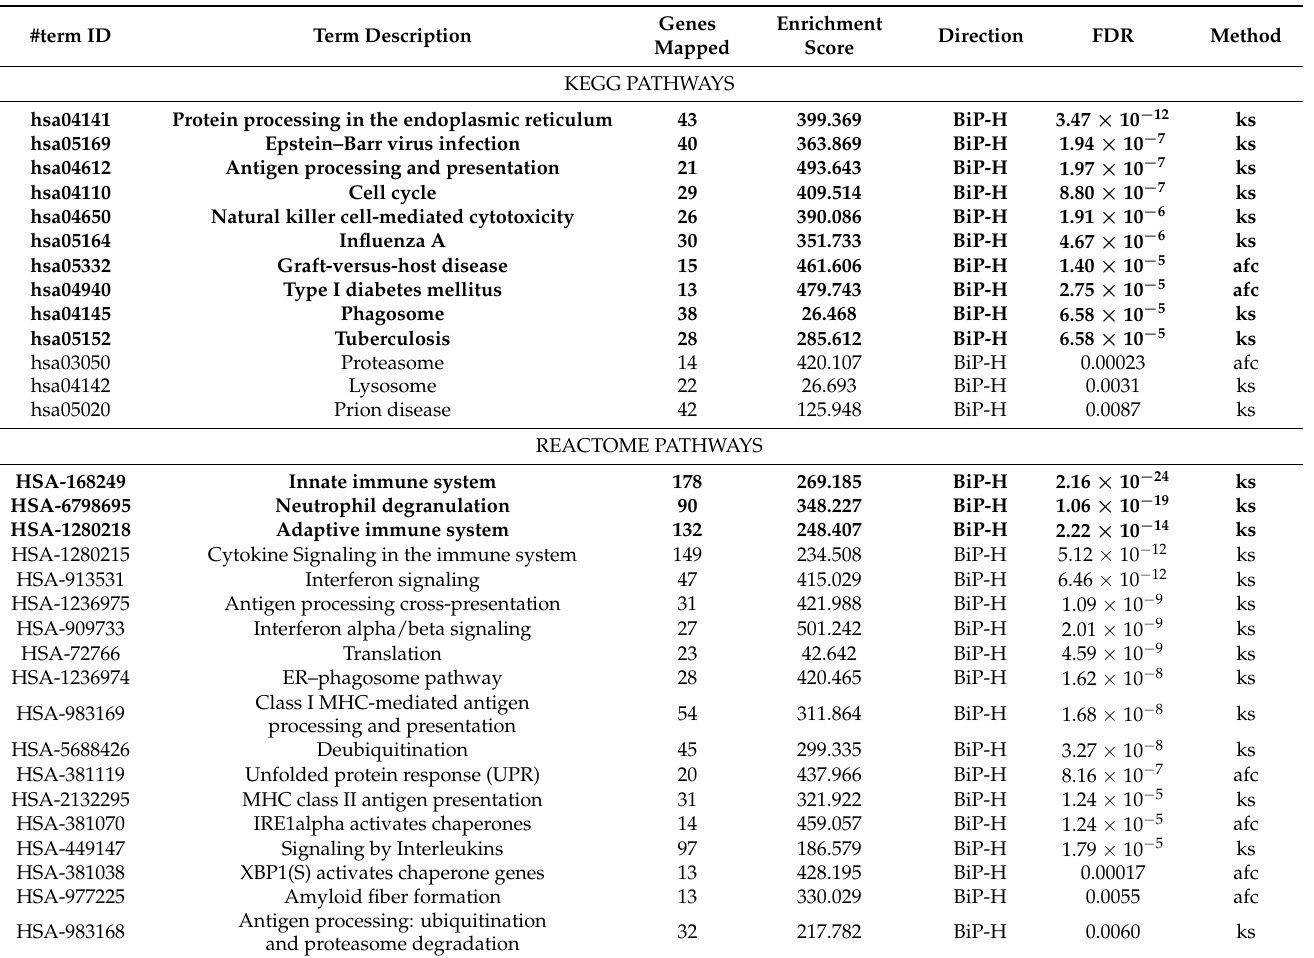
Table 2. Overrepresented pathways in TCGA PanCancer Atlas dataset stratified by BiP-High (BiP-H) and BiP-Low (BiP-L)